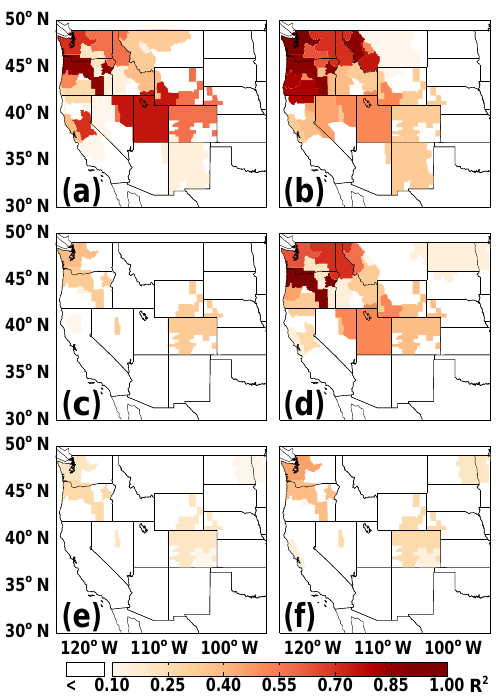
Figure 6. R 2 values for the following pairs of Google Trends search terms: (a) “air quality” and “wildfire”, (b) “air quality” and “smoke”, (c) “air quality” and “haze”, (d) “wildfire” and “smoke”, (e) “wildfire” and “haze”, and (f) “smoke” and “haze” for June– September